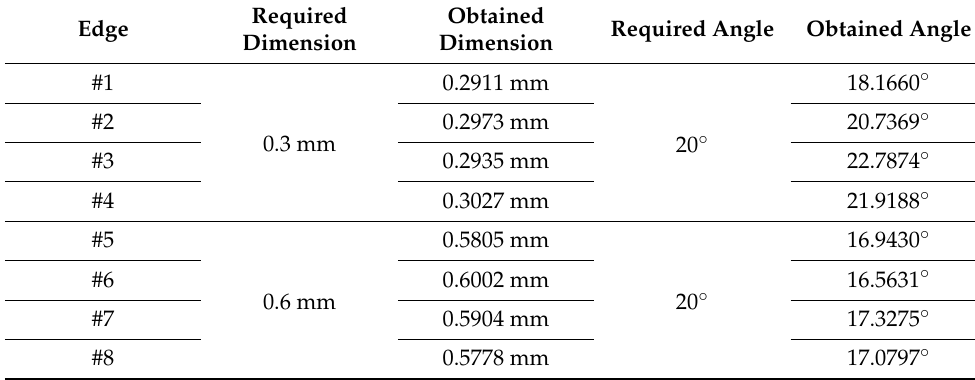
Table 2. Required and obtained values for asymmetrical chamfers.